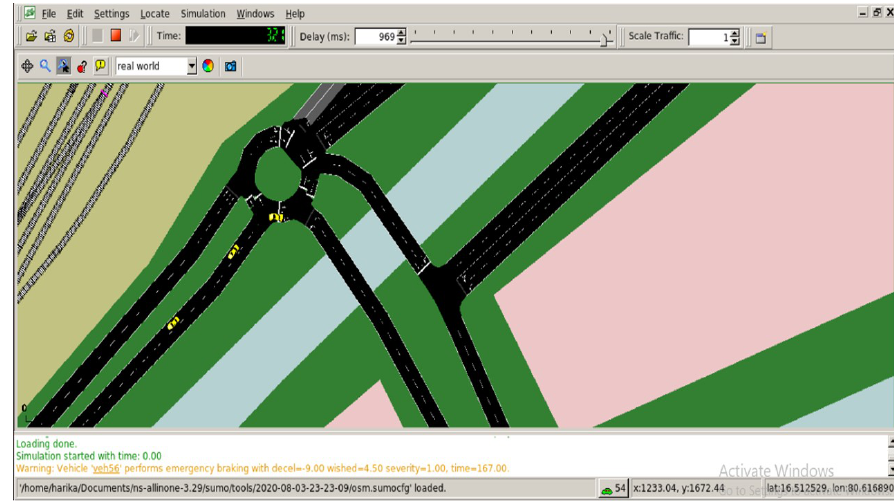
Figure 7. Vehicular traffic in SUMO.